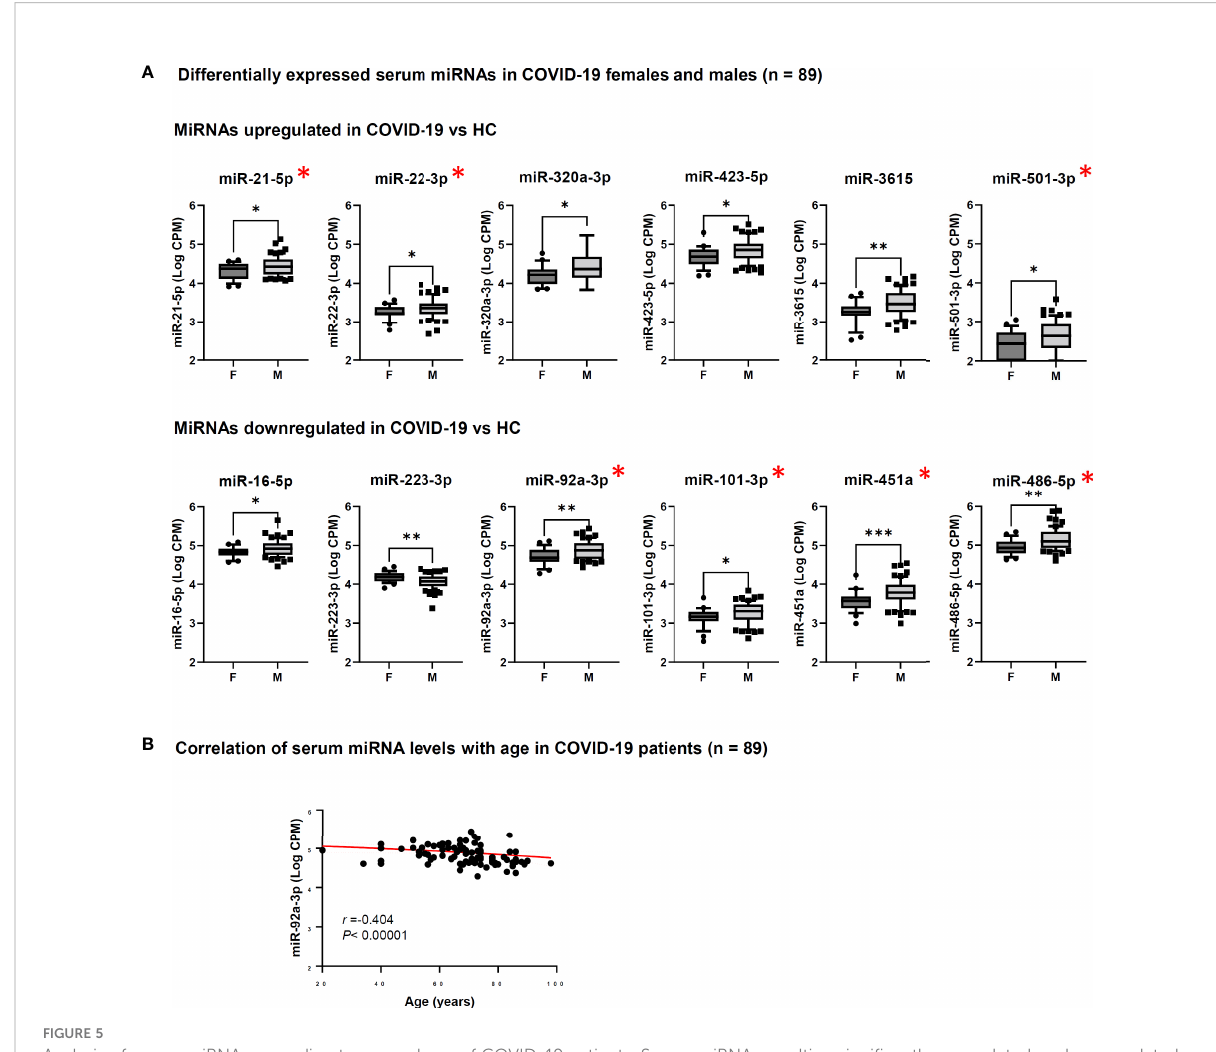
FIGURE 5 Analysis of serum miRNAs according to sex and age of COVID-19 patients. Serum miRNAs resulting signi fi cantly upregulated or downregulated in COVID-19 patients vs. healthy controls (HC) were included in the analyses. The red asterisk indicates miRNAs resulting signi fi cantly upregulated in patients with severe COVID-19 vs. mild/moderate COVID-19. (A) Comparison of serum miRNA levels between male (M, n = 62) and female (F, n = 27) COVID-19 patients was done by Mann-Whitney test. *p<0.05; **p<0.01; ***p<0.001. (B) Correlation between serum miRNA levels and age (years) of COVID-19 patients (n = 89) was done by Spearman rank correlation analysis. F, female; M, male. r : Spearman ’ s correlation coef fi cient. A statistically signi fi cantly correlation was found for